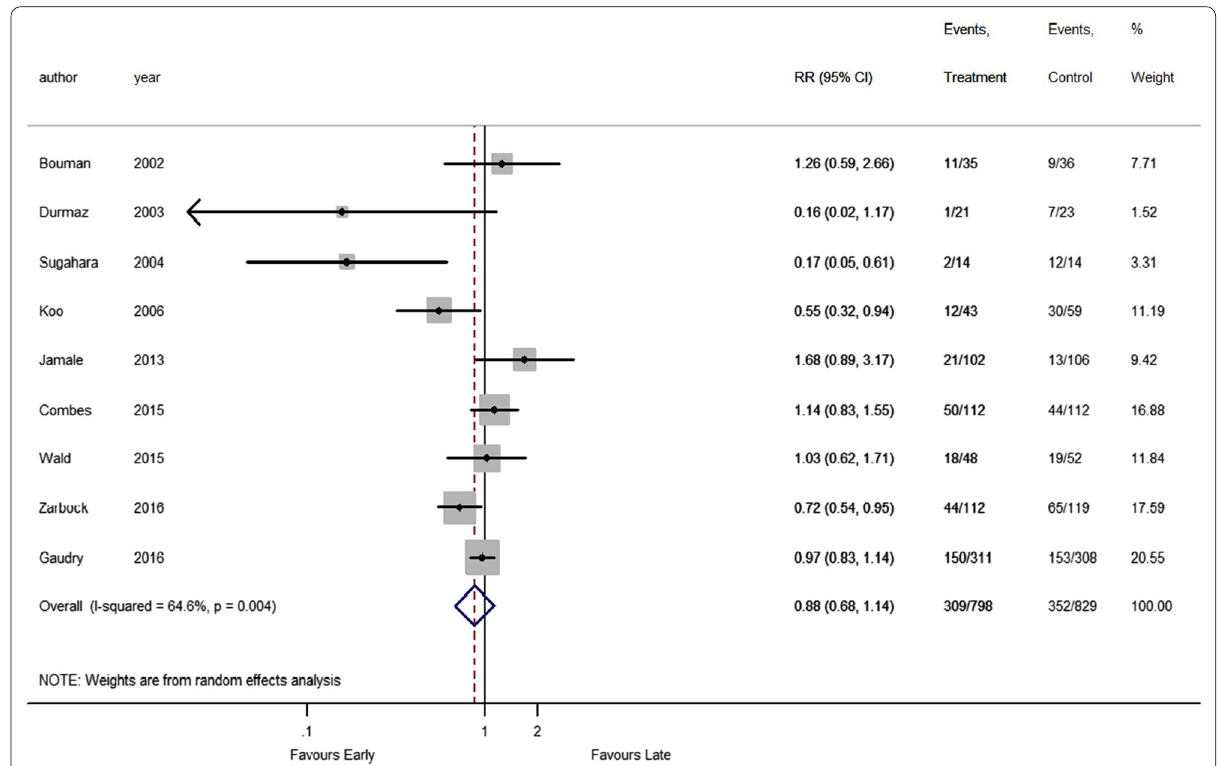
Fig. 2 Forest plot for all‑cause mortality: all studies. RCT randomized controlled trials, RRT renal replacement